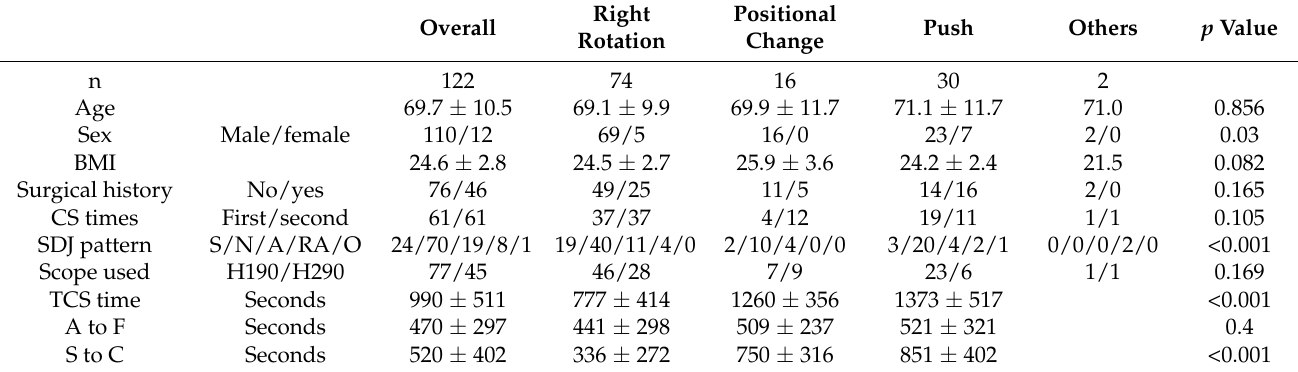
Table 3. Relationship between the pattern for passing through the hepatic flexure, demographic characteristics, and colonoscopy